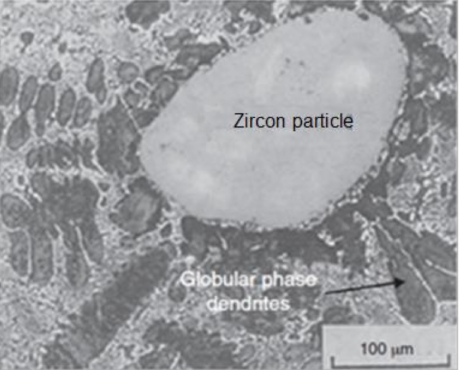
Figure 6. Optical micrograph of ZAS alloy showing a hypoeutectic Zn-rich primary-phase dendrites distribution [119].